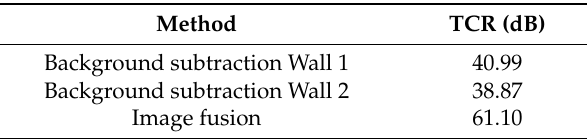
Table 2. Comparison of single target 2-wall case.